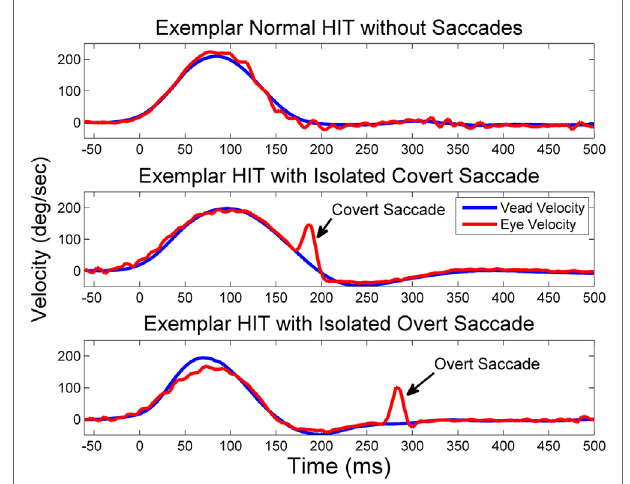
FigUre 1 | exemplar hiTs with and without saccades . Exemplar vHITs showing the presence of a normal response without saccades (upper pane), an isolated covert compensatory saccade (middle pane), and an isolated overt saccade (lower pane). Saccades are indicated by arrows. Eye velocity (red) has been inverted and shown superimposed on head velocity (blue).